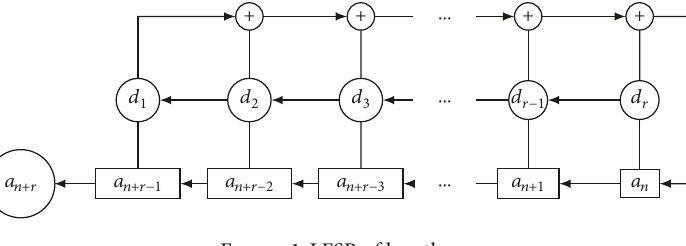
Figure 1: LFSR of length 𝑟